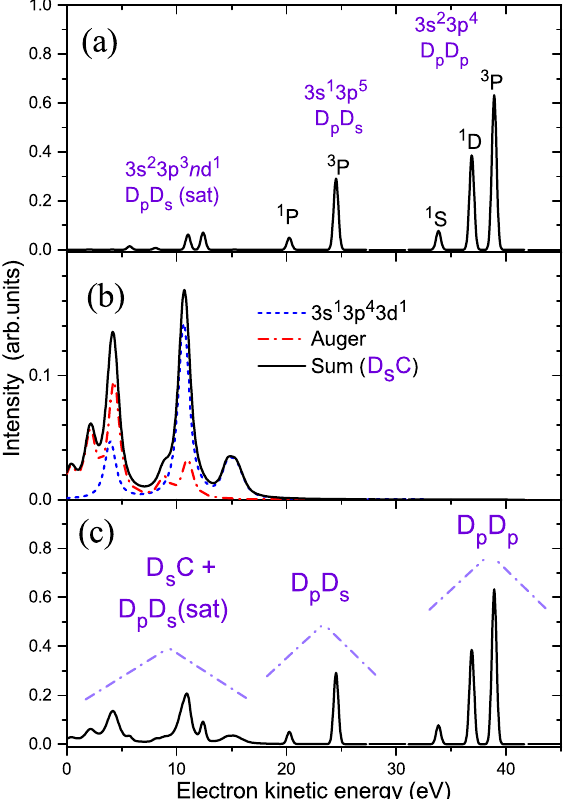
Figure 5. The 2PDI II PES of Ar for photon excitation energy 65.3 eV; ( a ) direct D p D p and D p D s processes; ( b ) D s C correlational process: photoelectron lines of processes (4) and (7) (3 s 1 3 p 4 3 d 1 ); Auger lines of process (14) (Auger) and total spectrum (Sum); ( c ) the sum of the spectra depicted in panels ( a , b